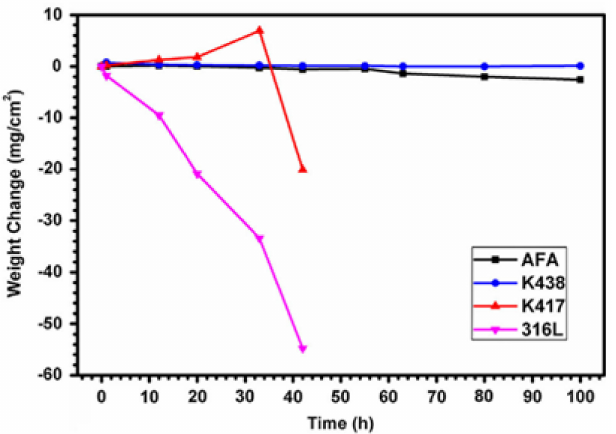
Figure 10. Weight change of the specimens hot-corroded at 1173 K in molten sodium sulphate